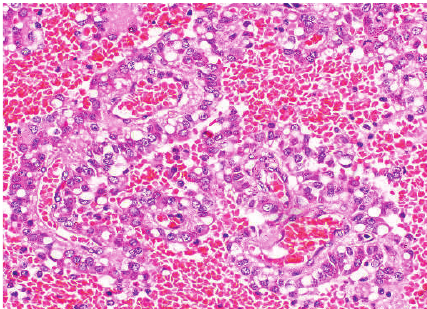
Figure 8: Haematoxylin and eosin stained section showing focus of partial capsular infiltration by the tumour ( ×